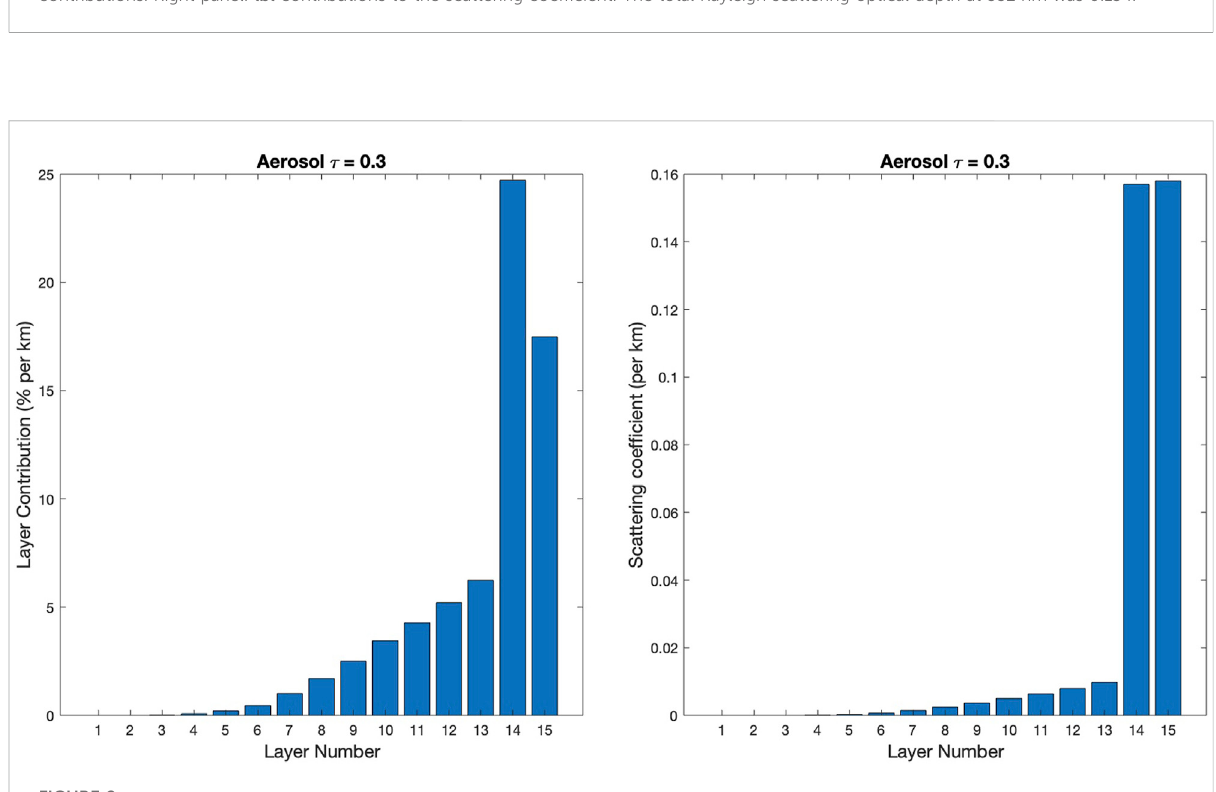
FIGURE 2 Same asFigure 1 exceptthat aerosol particlesweremixed withthemolecules inlayers 14and15.The totalAODoflayers 14and 15wastakento be